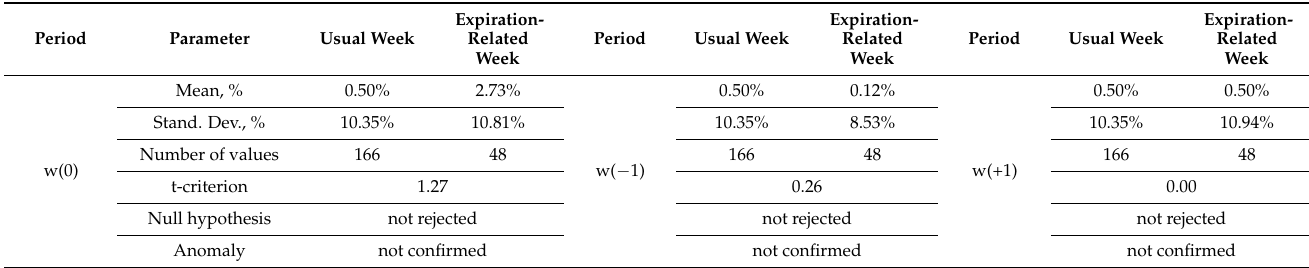
Table A10. T-test of the expiration price effects.